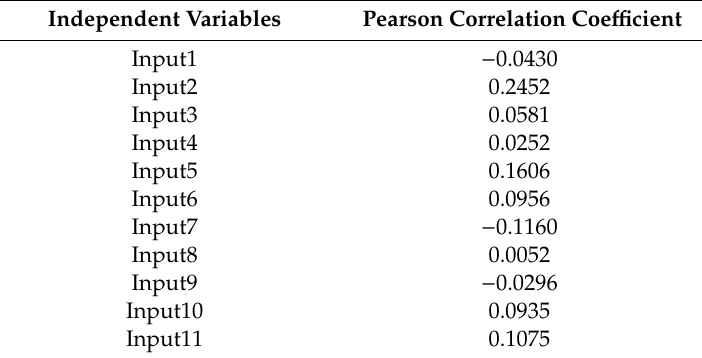
Table 2. The Pearson correlation coe ffi cient for each input.